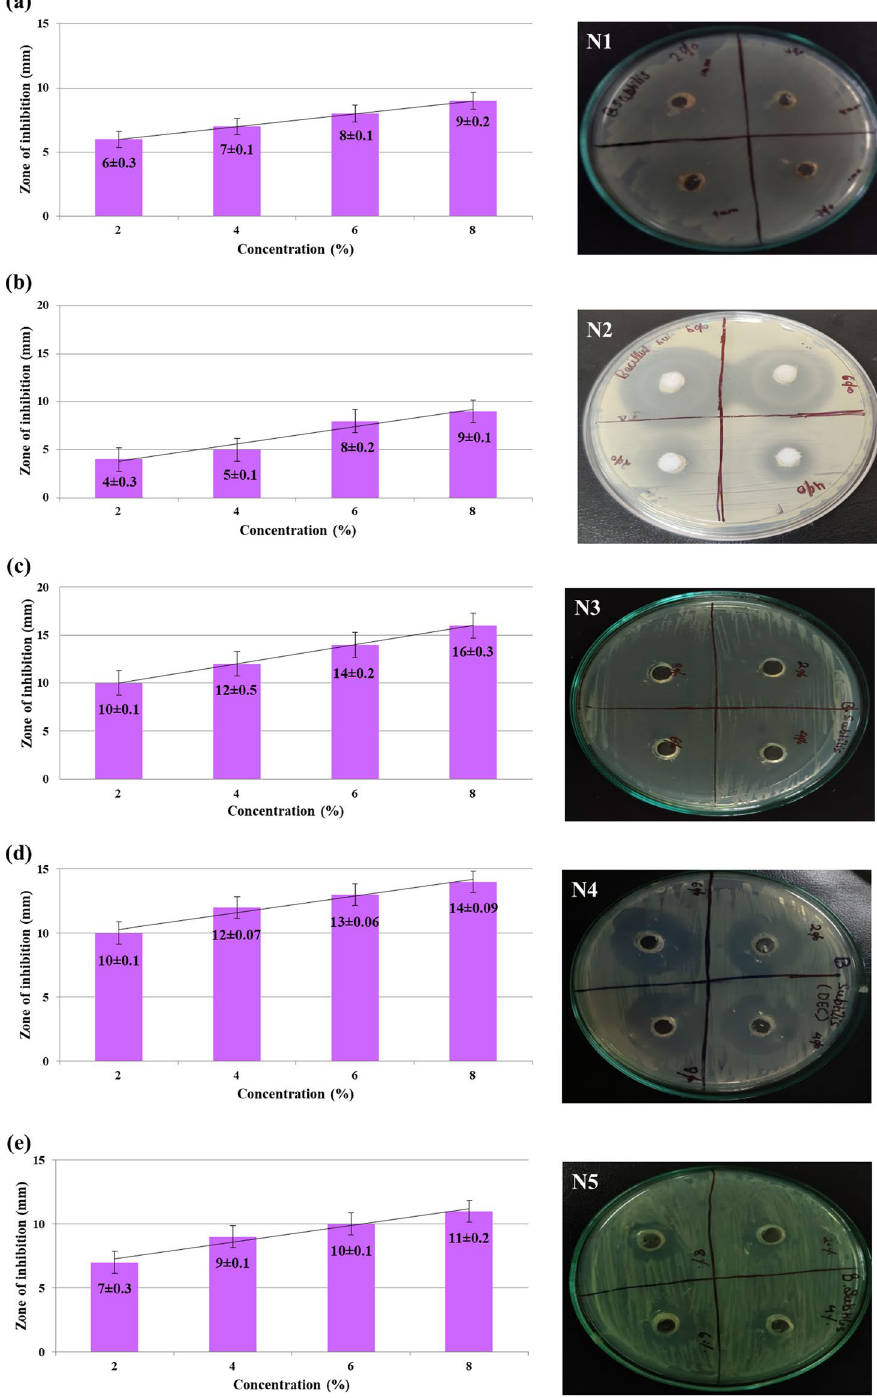
Figure 5. Zone of inhibition of acrylonitrile adducts against B. subtilis shown by agar-well method via culture plates and histograms showing relationship between sample concentration and zone of